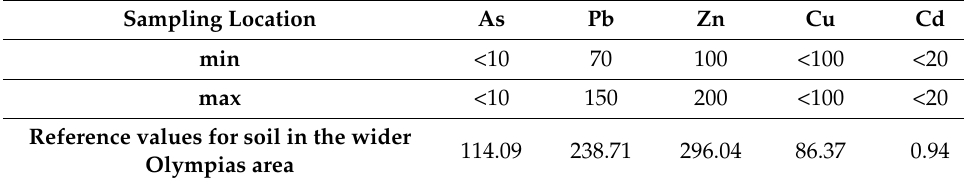
Table 5. Chemical analysis of soil used to cover the site after remediation (ppm). Sampling